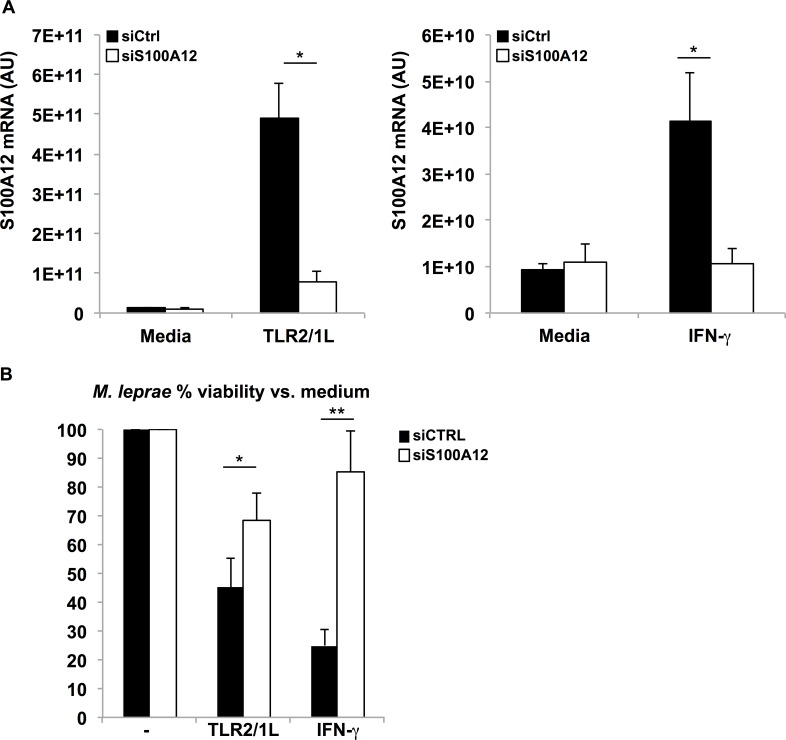
S100A12 plays a role in macrophage antimicrobial activity against M. leprae.
(A) MDMs were transfected with siRNA targeting S100A12 (siS100A12) or non-targeting siRNA (siCtrl). qPCR results displaying arbitrary unit (AU) of S100A12 mRNA 24 hours after stimulation with TLR2/1L (n = 9) or IFN-γ (n = 5). (B) MDMs were infected with M. leprae and stimulated with TLR2/1L (n = 9) and IFN-γ (n = 8). M. leprae viability was determined by measuring RNA (16S) and DNA element (RLEP) and determining the % viability relative to respective media control. Data are represented as mean % viability ± SEM, *P
≤0.05, **P
≤0.01, ***P
≤0.001.